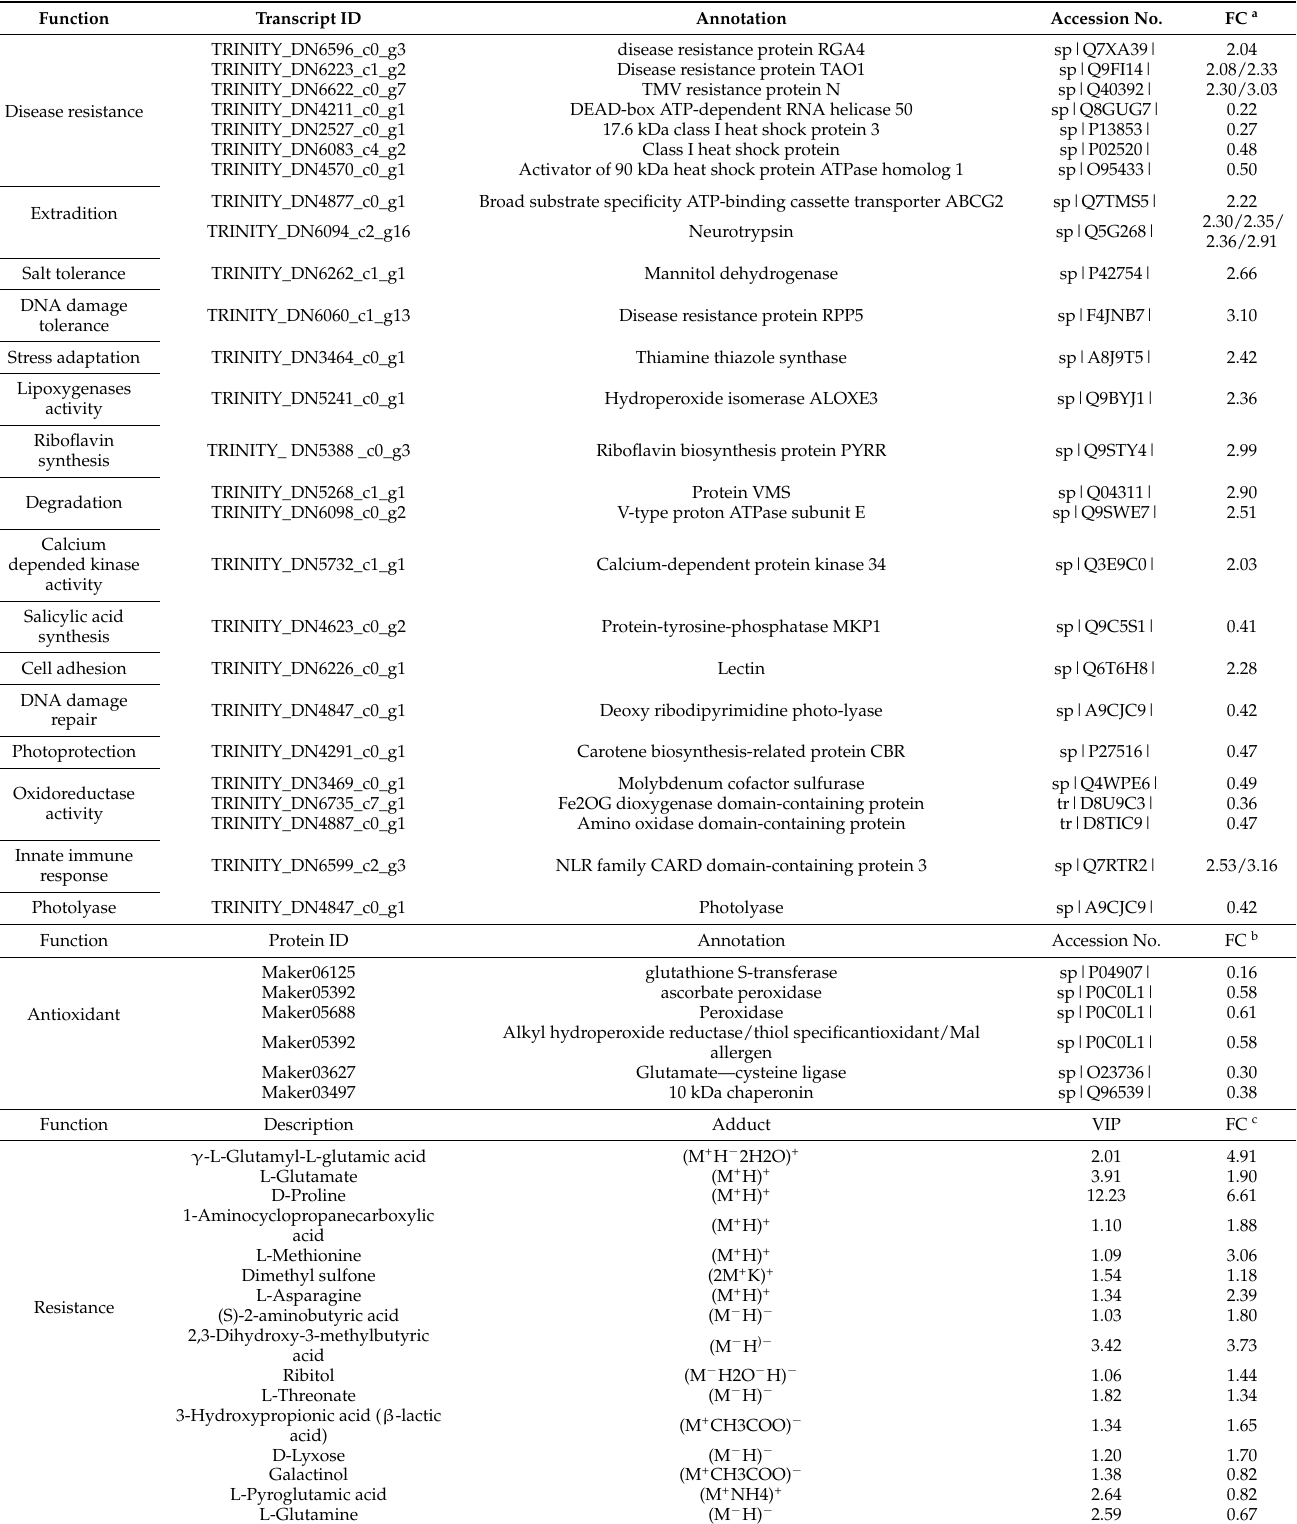
Table 6. Fluctuation of molecules in U. prolifera on resistance after 12 h treatment with high